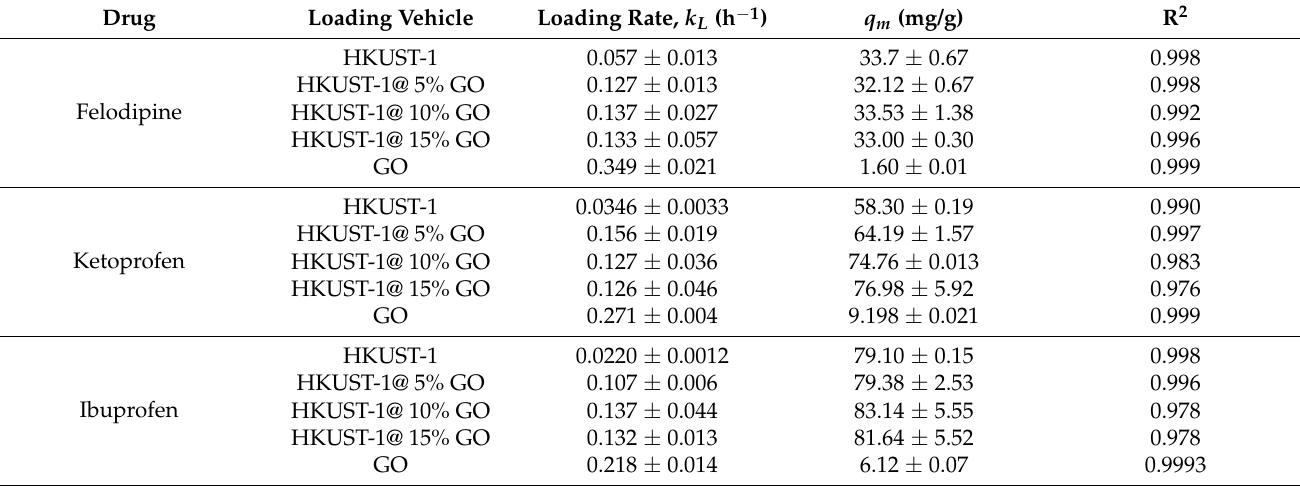
Table 2. Drug loading kinetic parameters for the different drugs onto MOF/GO composite materials with different amounts of